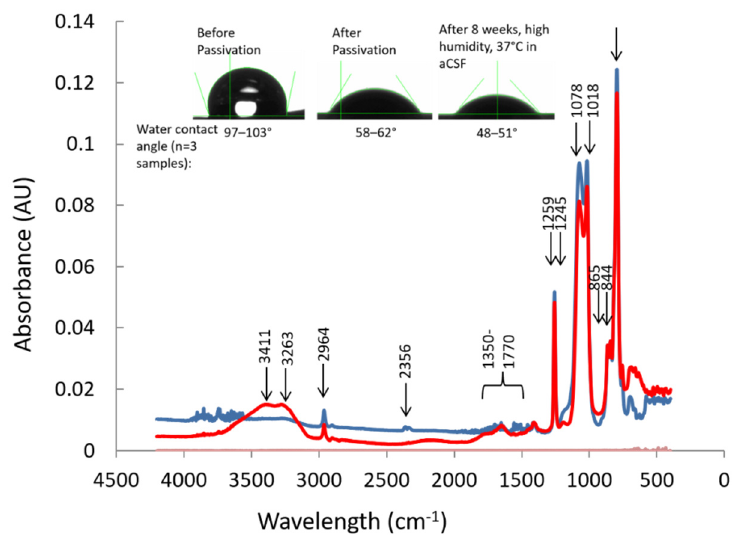
Figure 3. FTIR-ATR fingerprint regions of PDMS (blue) and soft brain-like composite (red). FTIR spectra displayed the unique chemical bond vibrational characteristics at specific frequencies for each of the above two materials (indicated by arrows) when stimulated with an infrared (IR) source. Inset shows the water contact angles before and after passivation where surface properties were maintained for up to 8 weeks.